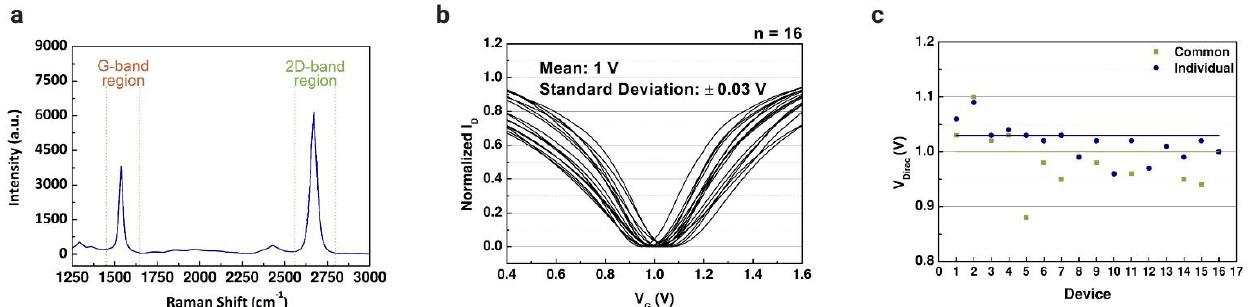
Figure 4. Characterization of common-gate graphene-based field-effect transistors. ( a ) Raman spectra (532 nm wavelength; G peak: 1537 cm − 1 and 2D peak: 2670 cm − 1 ) of the chemical vapor deposition (CVD)-grown graphene layers that was transferred using polydimethylsiloxane (PDMS) as supportive layer. ( b ) Normalized average transfer curves (n = 16) using 1 × phosphate-buffered saline (PBS) (pH 7.4) as a buffer solution. ( c ) Comparison between the Dirac point voltage values of the common-gate GFET (mean = 1 ± 0.03 V) and the individual gate GFET (mean = 1.03 ± 0.06 V).